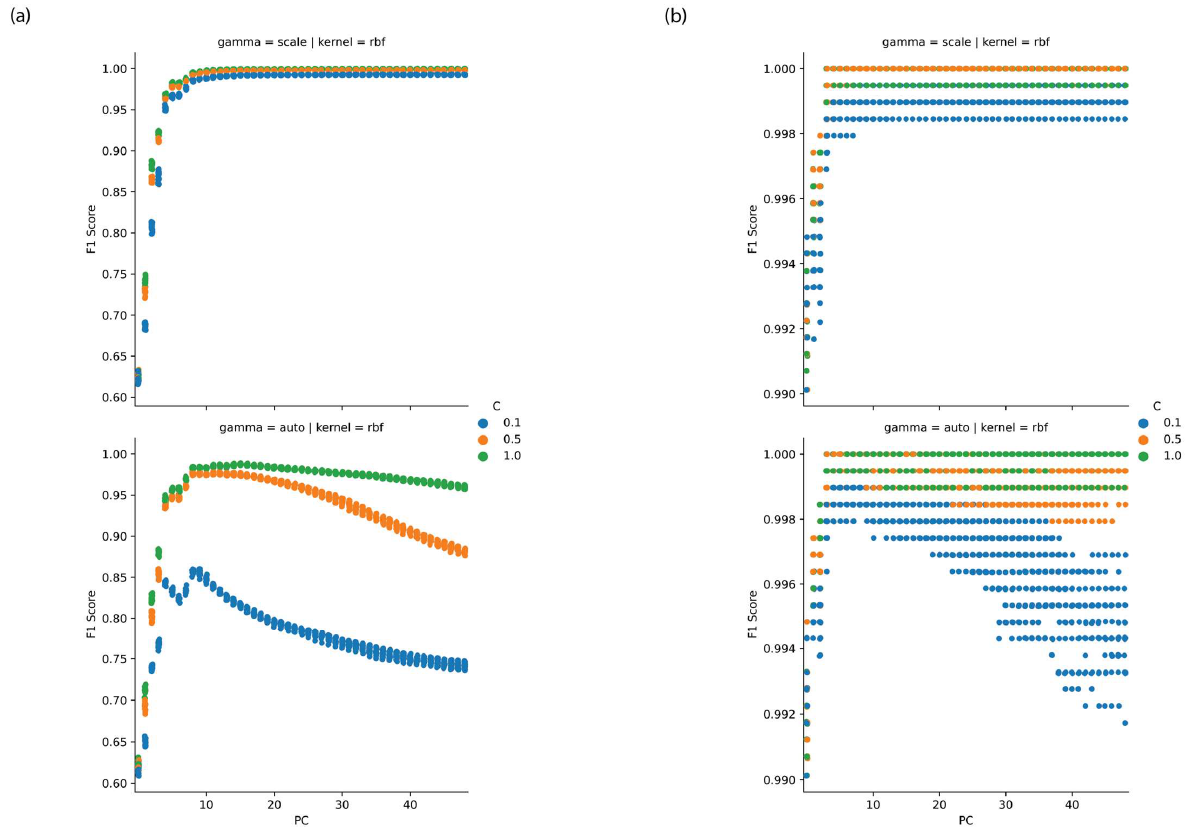
Figure 4. Performance of PCA-SVM versus principal component for ( a ) PNT1A and ( b ) LNCaP cell lines with variation in SVM hyperparameters.